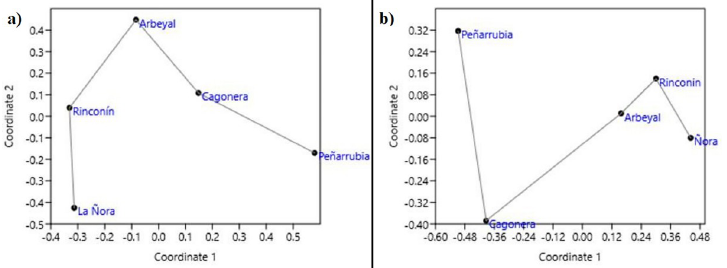
Fig 4. Non-metric multidimensional scaling analysis of the litter composition (a) and the litter biofouling biota identified from DNA (b) , in the five analyzed beaches. Scatter plots constructed from pairwise Gower distances. The minimum spanning tree is